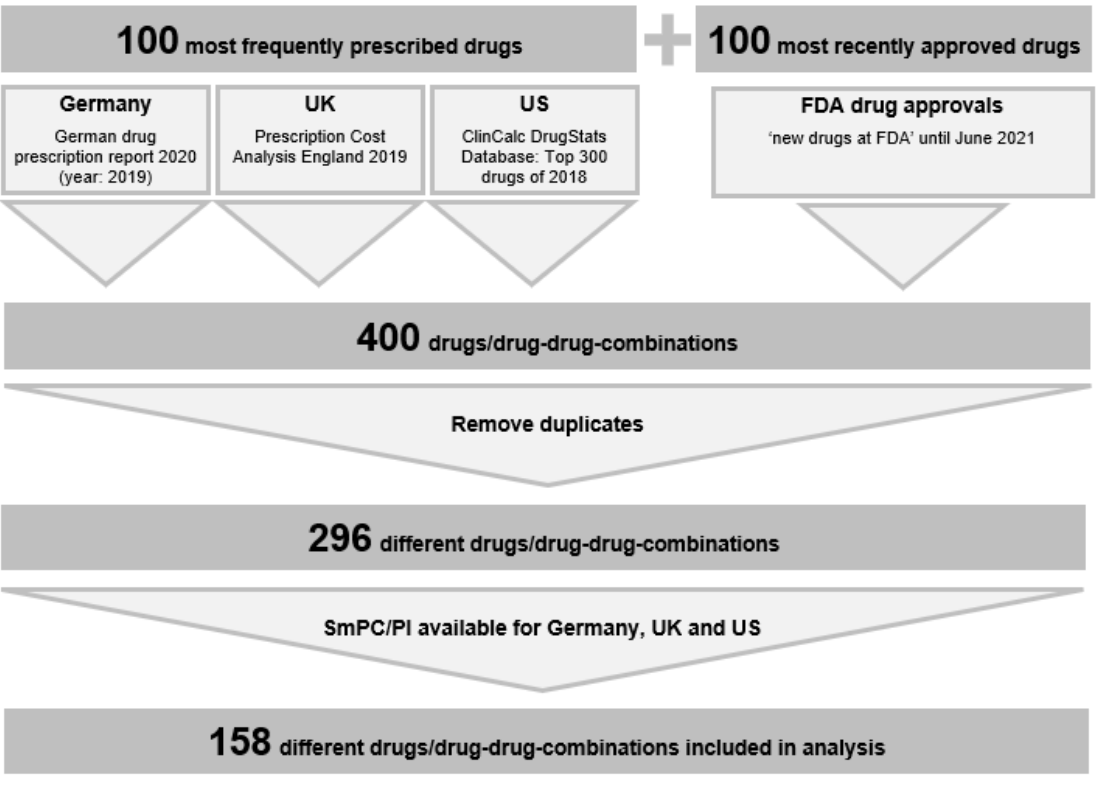
Figure 1. Selection of drugs for analysis.